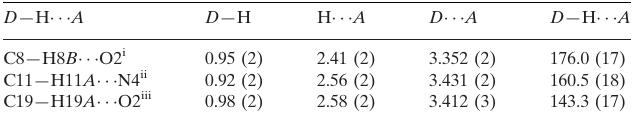
Hydrogen-bond geometry (A˚ , (cid:2)